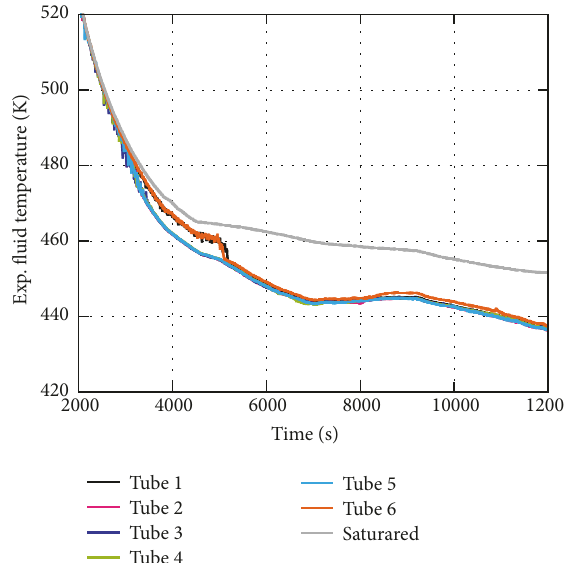
Figure 22: TR-LF-17 test results for fluid temperatures near top of SG U-tubes in loop A.